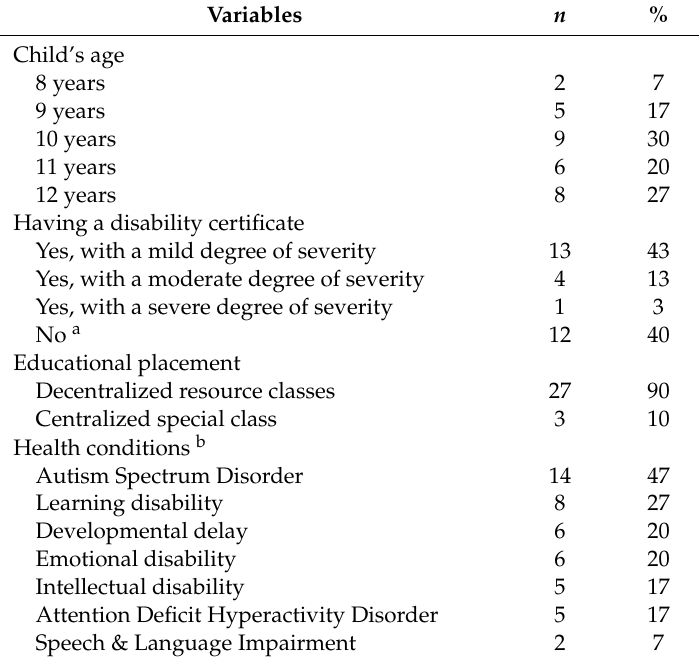
Table 1. Demographic information of children ( n =